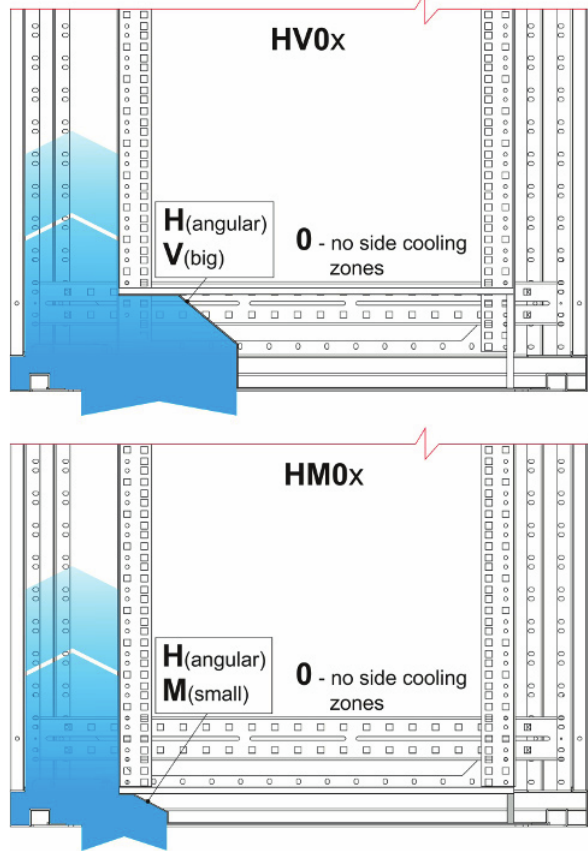
Fig. 3. Original used geometry and position for flow